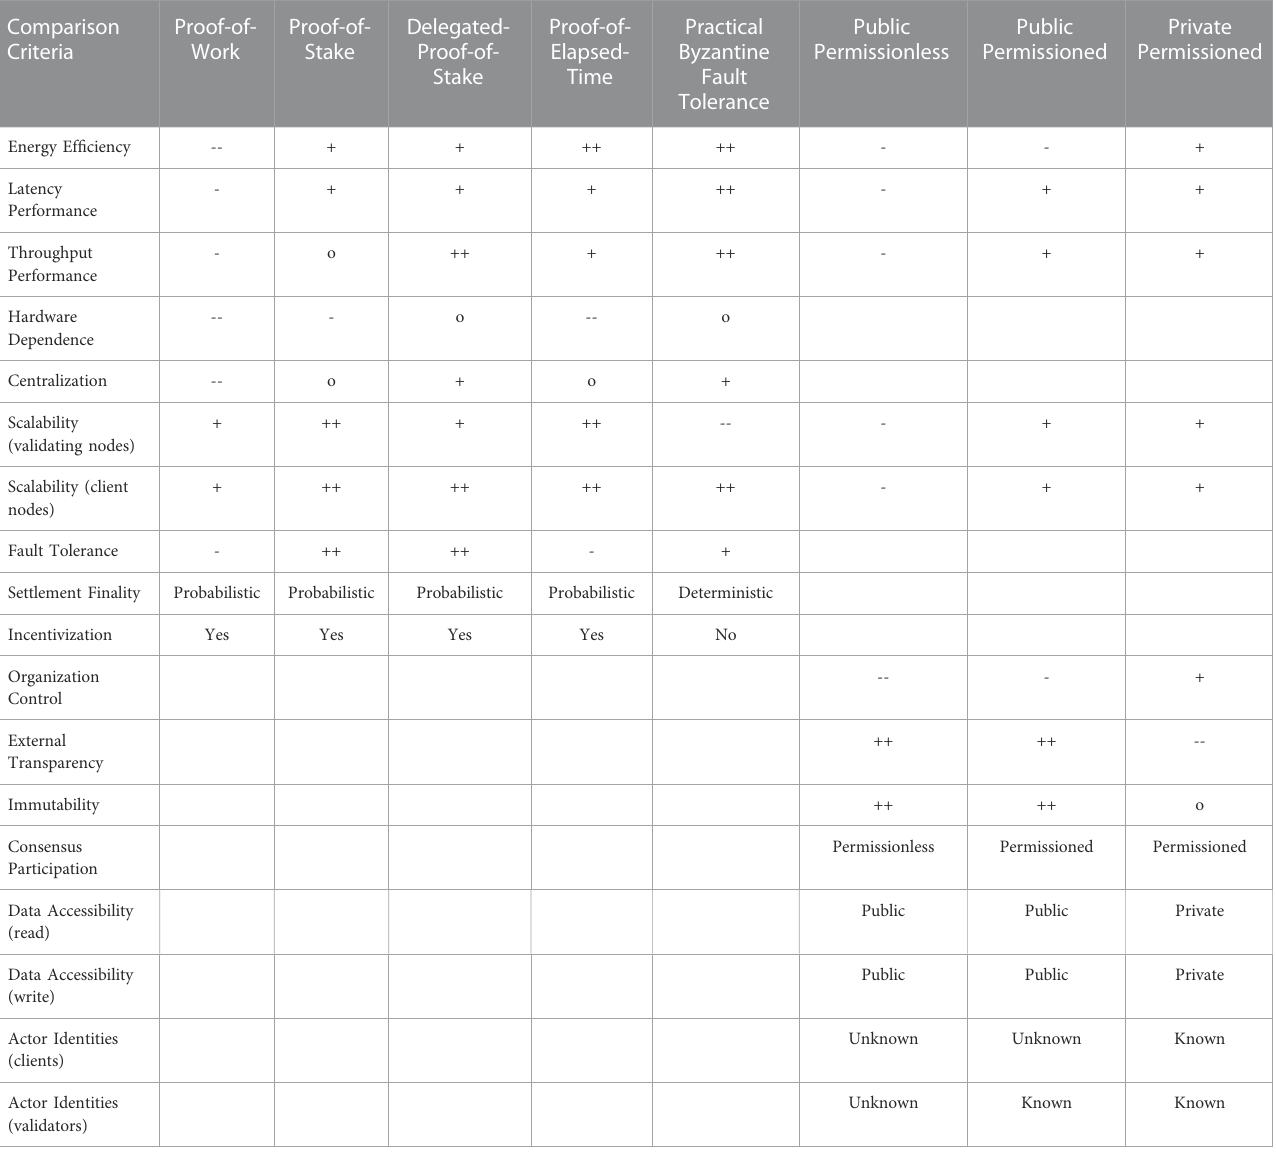
TABLE 1 Design Feature